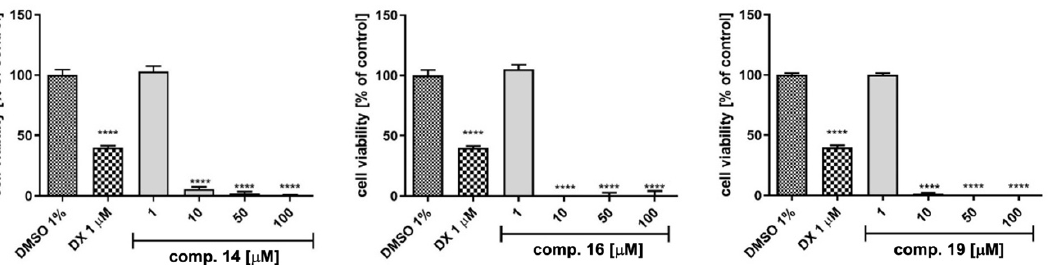
Figure 7. The effect of cytostatic drug doxorubicin (DX) and compounds 14 , 16 and 19 on hepatoma HepG2 cell lines’ viability after 72 h of incubation at 37 °C, 5% CO 2 . Statistical significance (**** p < 0.0001) was analysed by Graph Pad Prism 8.0.1 software using One-way ANOVA and Bonferroni’s multiple comparison post-test. The compounds were examined in